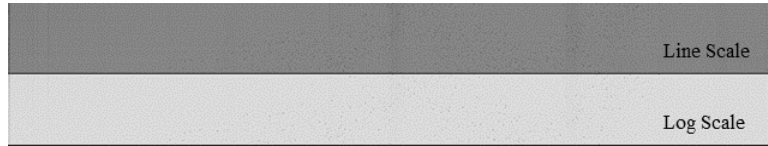
Figure 10. Image after yaw correction.